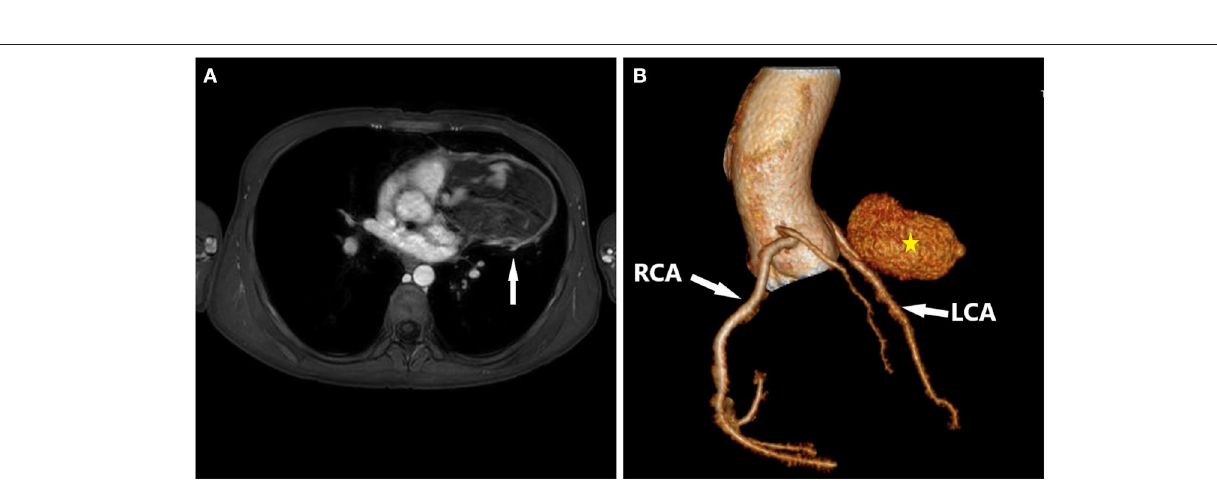
FIGURE 2 | Preoperative chest MRI and Postoperative cardiac CTA. (A) MRI showed a large mixed-signal shadow in the left side of the middle mediastinum, measuring about 9.8cm × 8.0cm, with multiple patchy T1W1 high-signal shadows within it, and enhanced scans showed nodular enhancement in the lesion, measuring about 2.6cm × 1.7cm. (B) Preoperative cardiac CTA showed the middle segment of the anterior descending branch of the left coronary artery was poorly displayed, and a localized sac-like enhancement shadow was seen, with a maximum cross-section of about 2.6cm ×